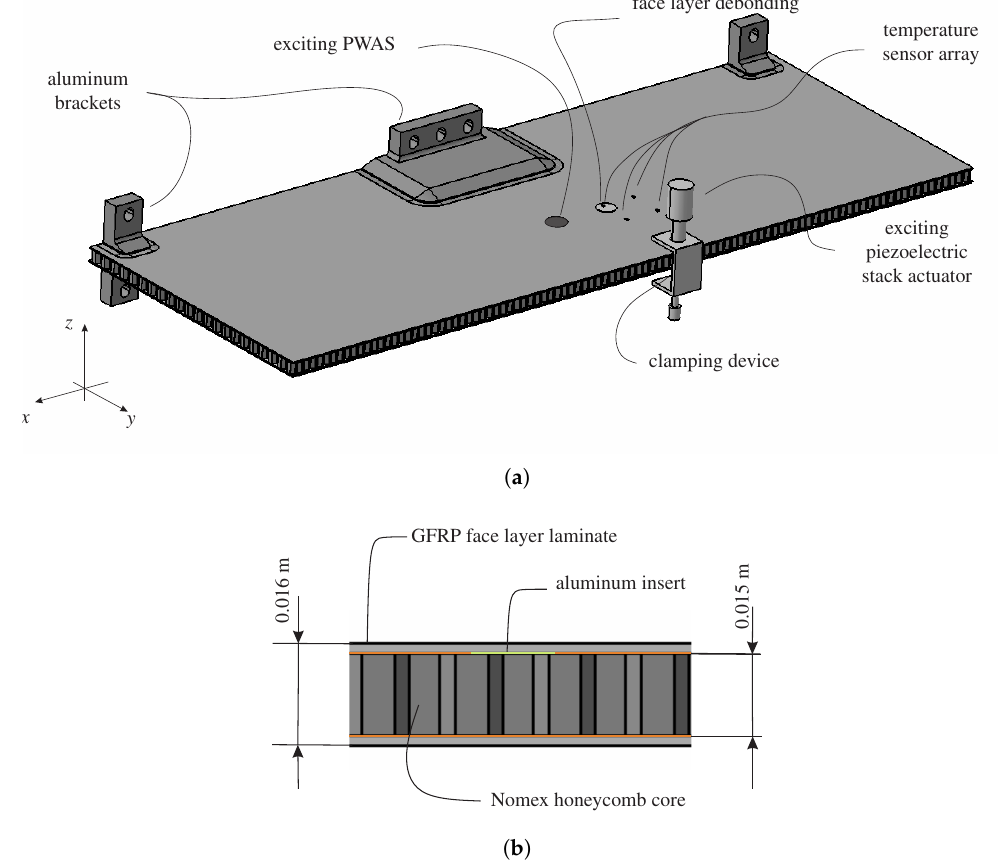
Figure 2. Investigated structure: ( a ) The investigated sandwich structure with the face layer debond- ing, excitation devices and surface temperature sensors ( b ) Cross-section of the investigated structure at the artificially introduced face layer